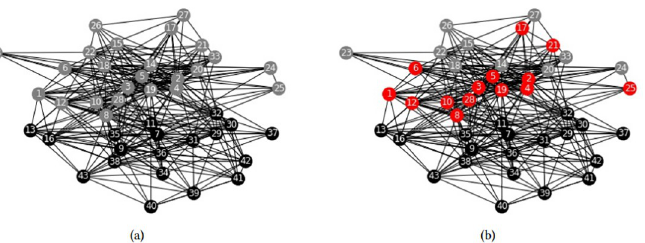
Fig 8. Windsurfers community structures. Community structures obtained by (a) F ∗ with parameters n p = 1, (b) F ∗ Sh (cid:0) Mod